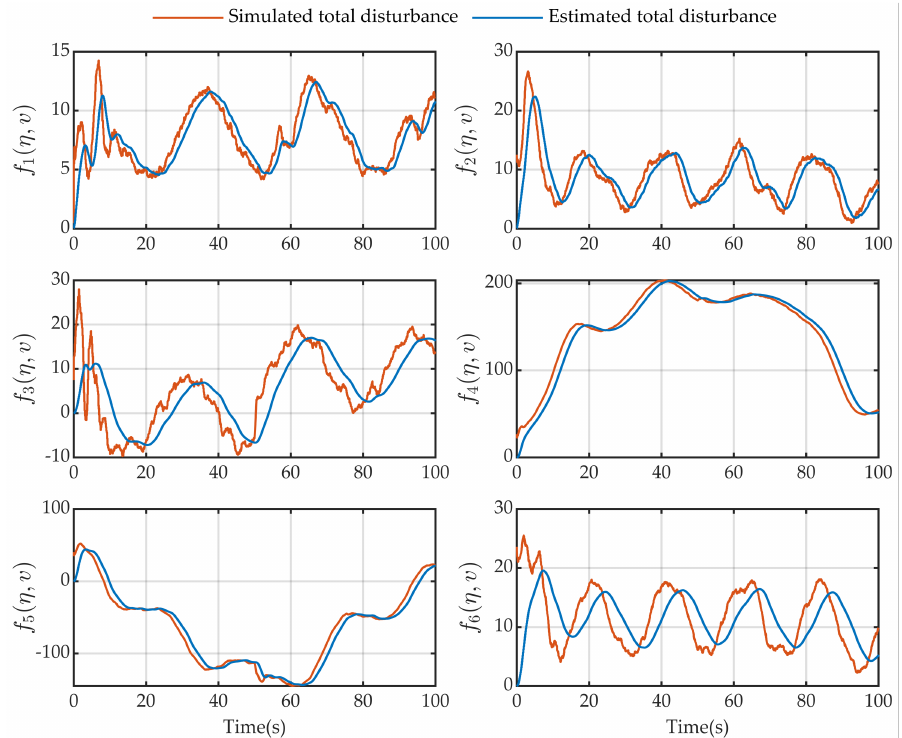
Figure 11. Comparison of estimated total disturbance and simulated total